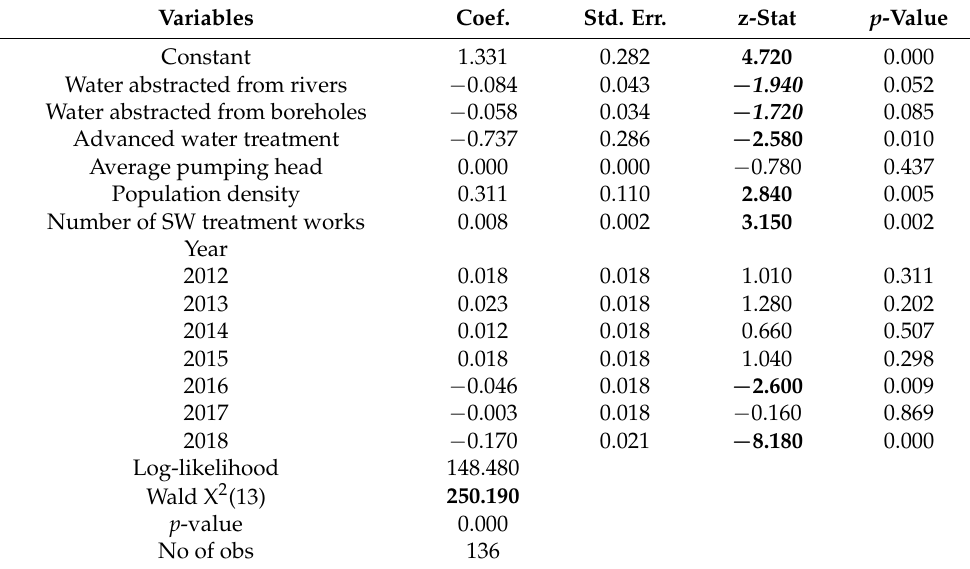
Table 4. Estimated results from the regression model to identify drivers of